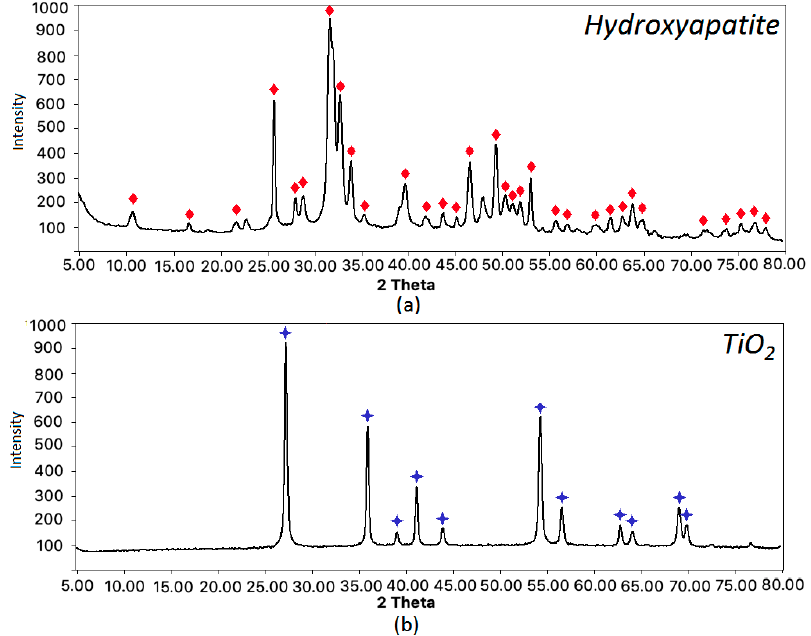
Figure 6. XRD analysis of the scaffolds components: ( a ) hydroxyapatite—the matching patterns are marked with red diamond; ( b ) titanium dioxide—the matching patterns are marked with blue stars.